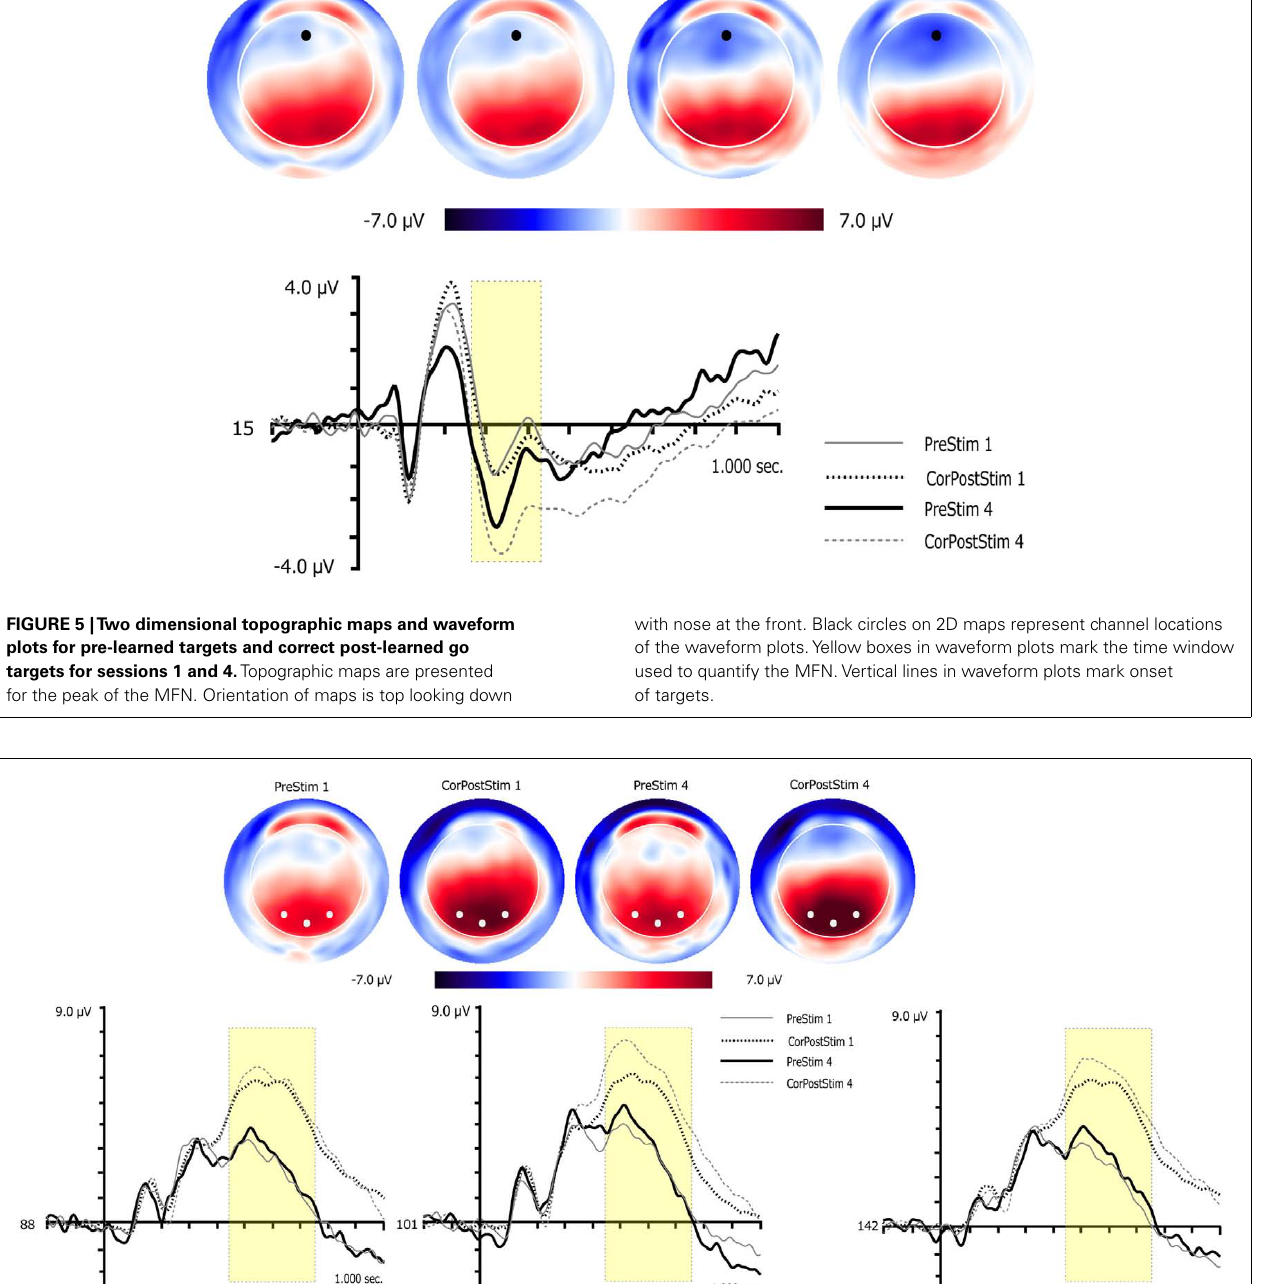
on 3D maps represent channel locations of the waveform plots.Yellow boxes in waveform plots mark the time window used to quantify the P3.Vertical lines in waveform plots mark onset of